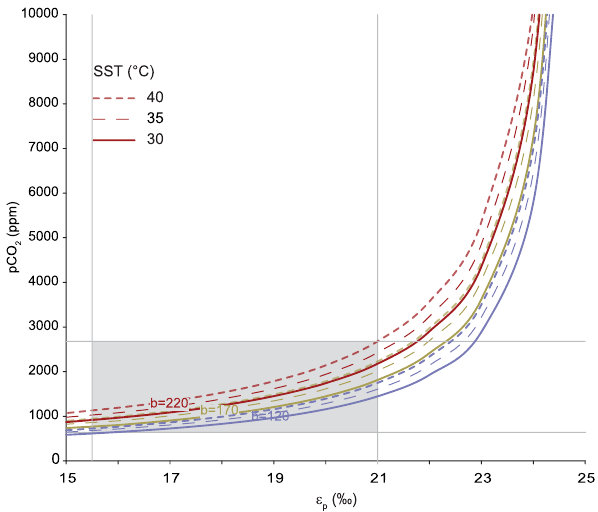
Fig. 6. The relationship between ε p and p CO 2 (figure modified from: Pagani, 2002; Bijl et al., 2010). The SST ranges are bases on the SSTs reconstructed with TEX 86 for the Cenomanian-Turonian. Values for b are based on values reconstructed for b at Demerara Rise (Bice et al., 2006) and on the values for b calculated in this paper. The grey area indicates the values for ε p calculated across the OAE-2